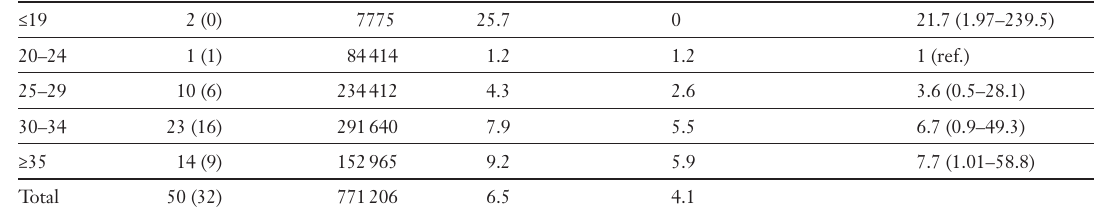
Maternal mortality by nationality and maternal age in Switzerland,